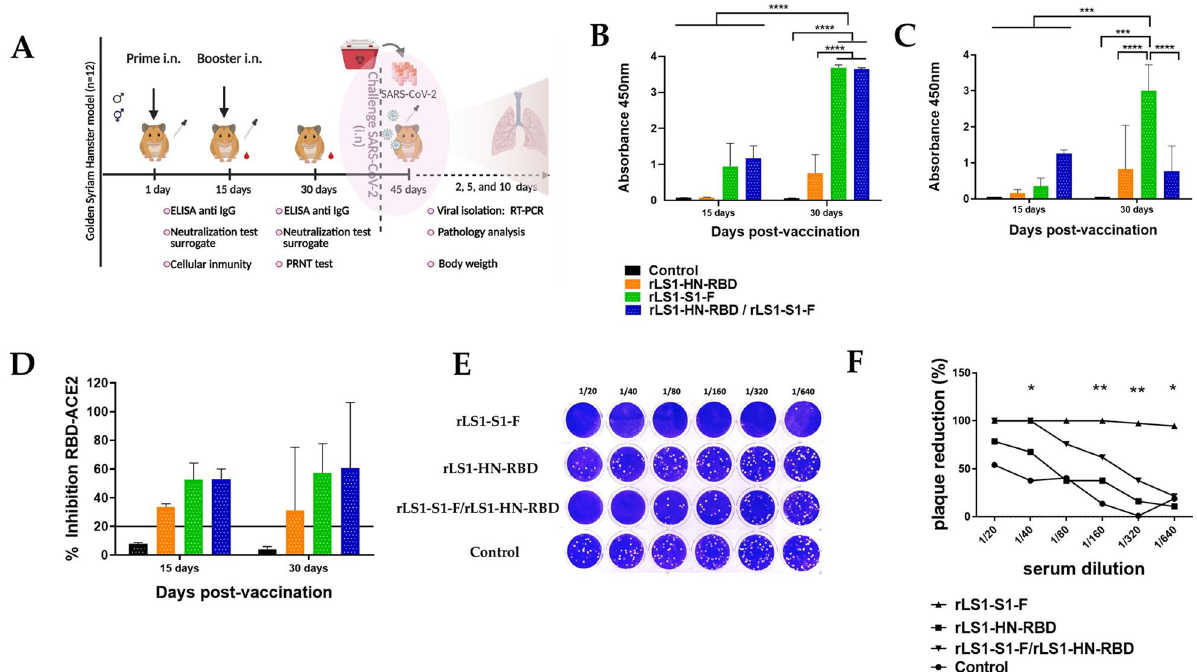
Figure 5. The intranasal vaccine elicits specific antibodies against RBD and S1 protein and neutralizing antibodies against SARS-CoV-2 in hamsters. ( A ) Immunization regimen. To evaluate the immunogenicity of the NDV vaccines, five- week-old female and male golden Syrian hamsters were used in this study. The hamsters were randomly divided into four groups. The hamsters were vaccinated by intranasal route with live NDV vaccine, following a prime-boost- regimen with a two-week interval. Group 1 received rLS1-HN-RBD ( n = 12), Group 2 received the rLS1-S1-F ( n = 12), Group 3 received the mixture of rLS1-HN-RBD/rLS1-S1-F ( n = 12), and Group 4 was the non-vaccinated control group ( n = 12) One booster immunization with the same concentration of each vaccine was applied in all vaccinated groups at the second week. ( B ) ELISA assay to measure SARS-CoV-2 RBD-specific serum IgG antibody, and ( C ) S1 subunit-specific serum IgG antibody. Sera from hamsters at pre-boost and 15 days after boost were evaluated. SARS-CoV-2 RBD purified recombinant protein was used for ELISA. The cutoff was set at 0.06. ( D ). Immunized hamsters were bled pre-boost and 15 days after boost. All sera were isolated by low-speed centrifugation. Serum samples were processed to evaluate the neutralizing antibody titers against SARS-CoV-2 RBD protein using the sVNT. The positive cut-off and negative cut-off for SARS-CoV-2 neutralizing antibody detection were interpreted as the inhibition rate. The cut-off interpretation of results: result positive ≥ 20% (neutralizing antibody detected), result negative < 20% (neutralizing antibody not detectable. ( E ) Figure depicts titers of PRNT of SARS-CoV-2 on Vero cells with pooled serum from hamsters immunized with rLS1-S1-F, rLS1-HN-RBD, and the mixture of both. ( F ) Plaque reduction (%) curves using pooled serum from the different groups of hamsters. Two-way ANOVA and Tukey’s post hoc were performed. * P < 0.05; ** P < 0.01; *** P < 0.001; **** P <